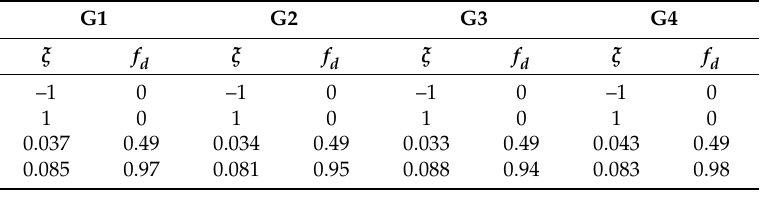
Figure 8. Power output of all generators related to Test Case 2.